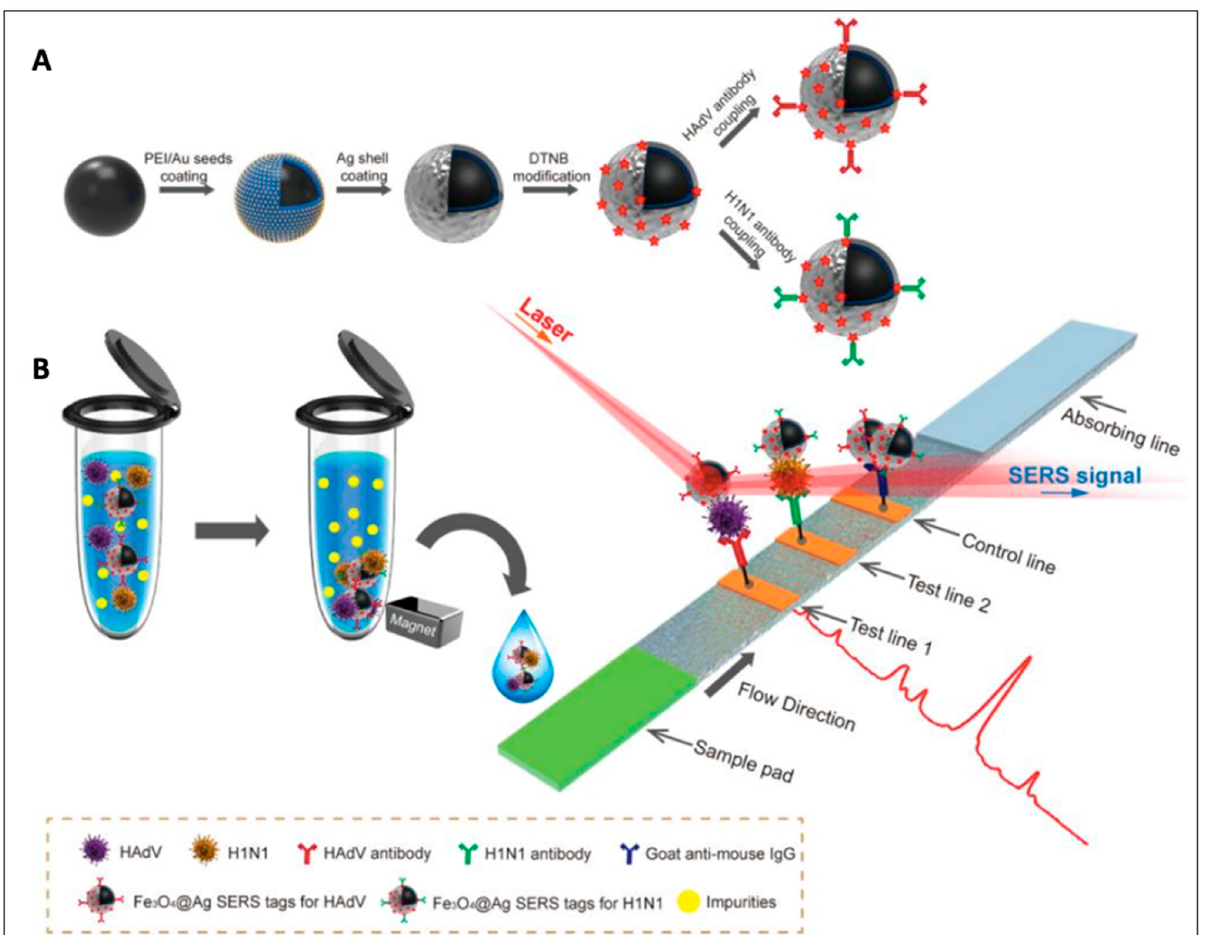
Figure 9. ( A ) Synthesis scheme for Fe 3 O 4 @Au SERS nanotags modified with antibodies. ( B ) Operating procedure of prepared SERS-LFIA strip for simultaneous detection of HAdV and FluA H1N1 viruses. Reprinted with permission from Ref. [134]. Copyright 2019 American Chemical Society.